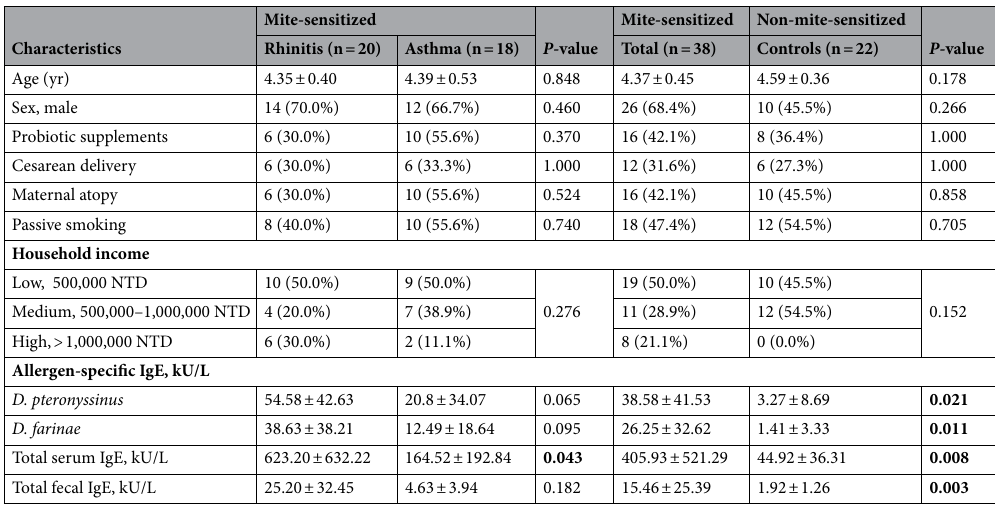
Table 1. Comparison of the clinical and epidemiologic characteristics between mite-sensitized rhinitis and asthma, and non-mite-sensitized healthy controls. All P -values < 0.05, which is in bold, are significant. Data shown are mean ± SD or number (%) of patients as appropriate. yr year, NTD New Taiwan Dollar, IgE immunoglobulin